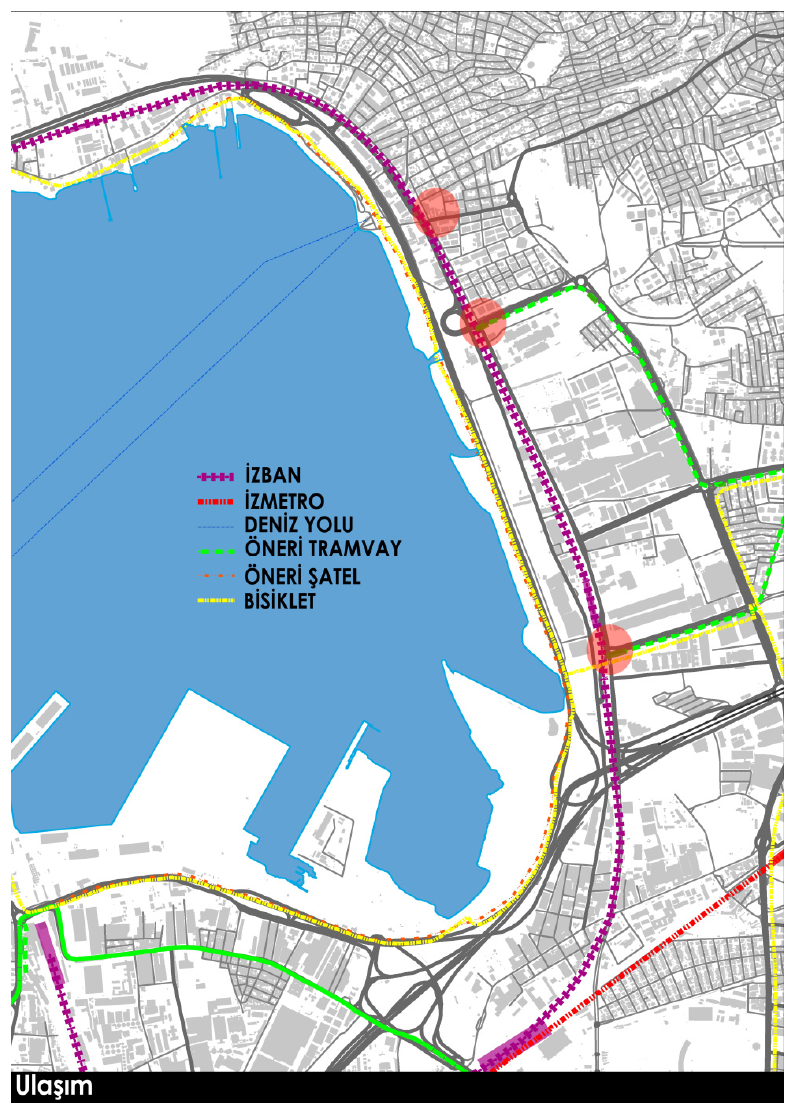
Figure 4. The main transportation axes passing through the Bayrakl ı District. Reproduced with permission from Metin K ı l ı ç; published by M+D Mimarl ı